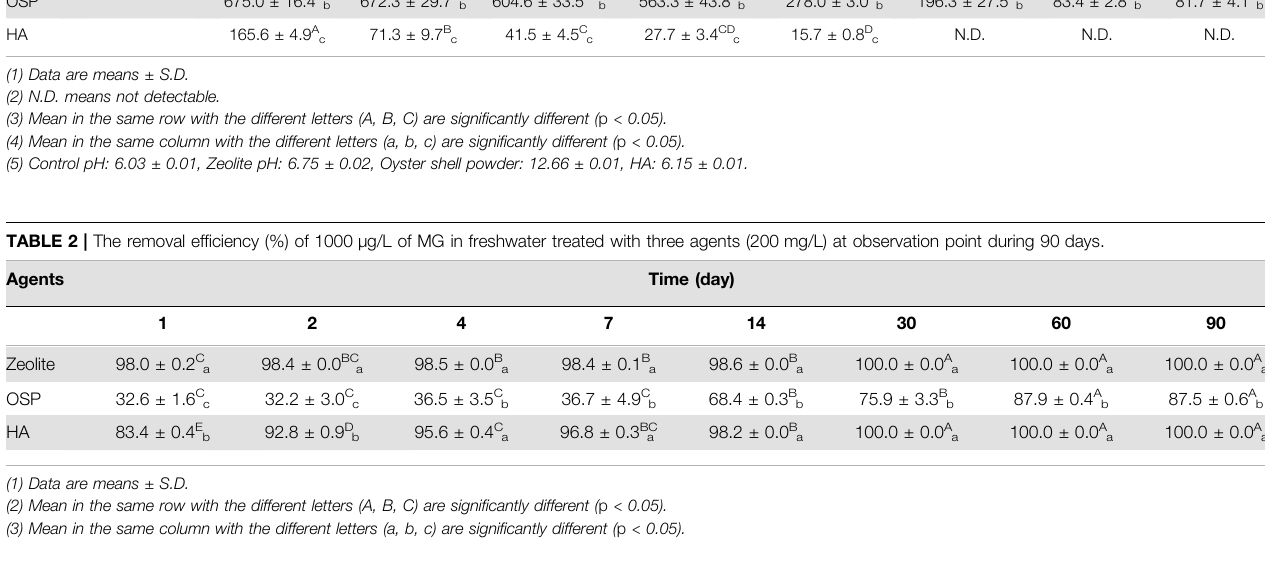
TABLE 3 | Concentrations of MG ( μ g/L) in seawater after treating with three agents (200 mg/L) at observation point during 90 days.